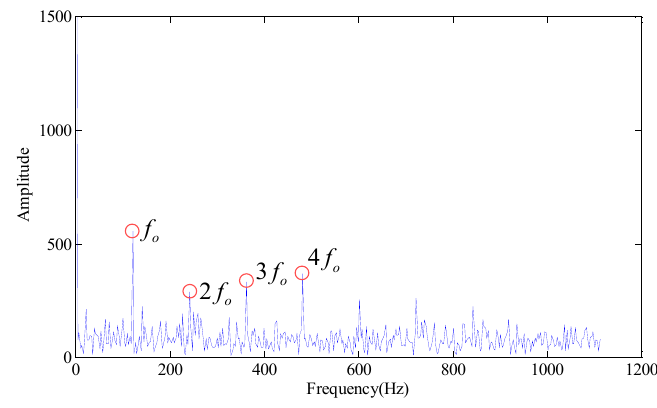
Figure 12. Envelope spectrum (Singular value 1).